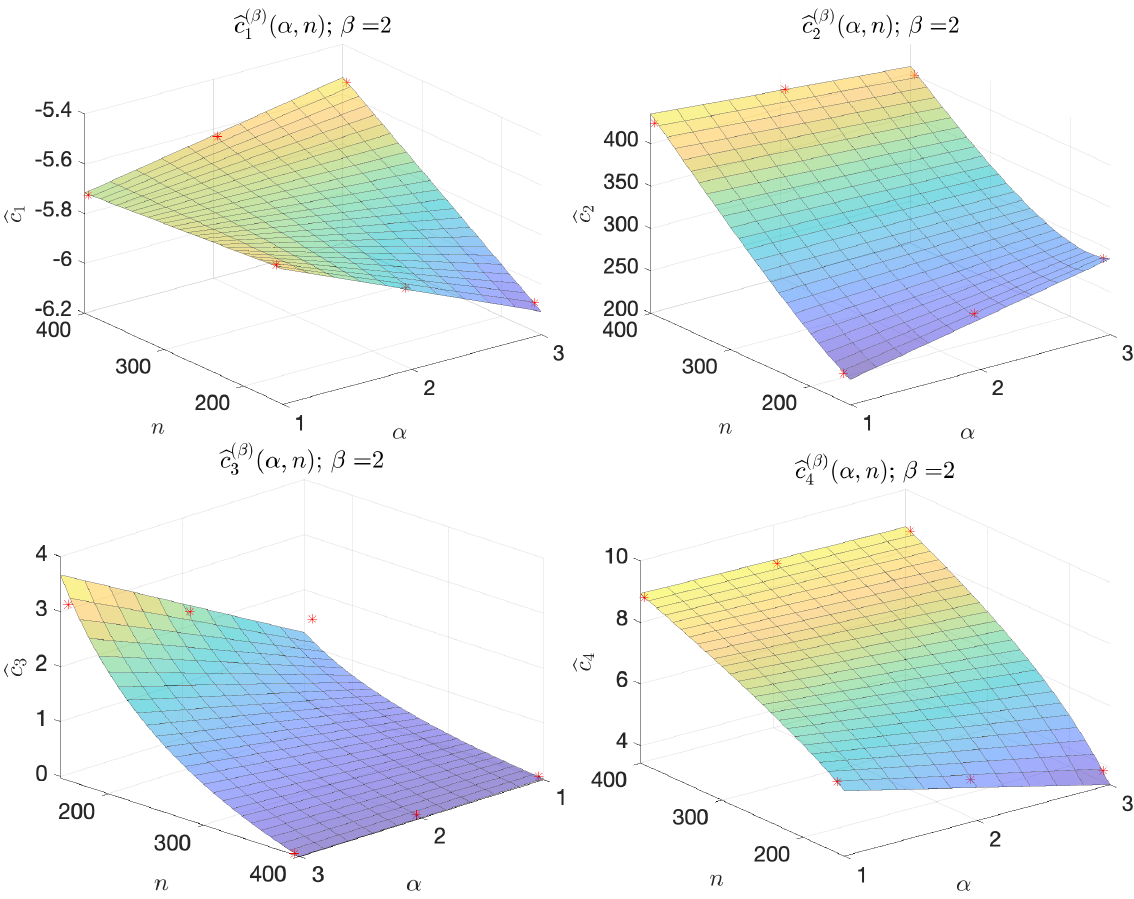
( β ) ( α , n ) fitting the coefficients (cid:98) c i